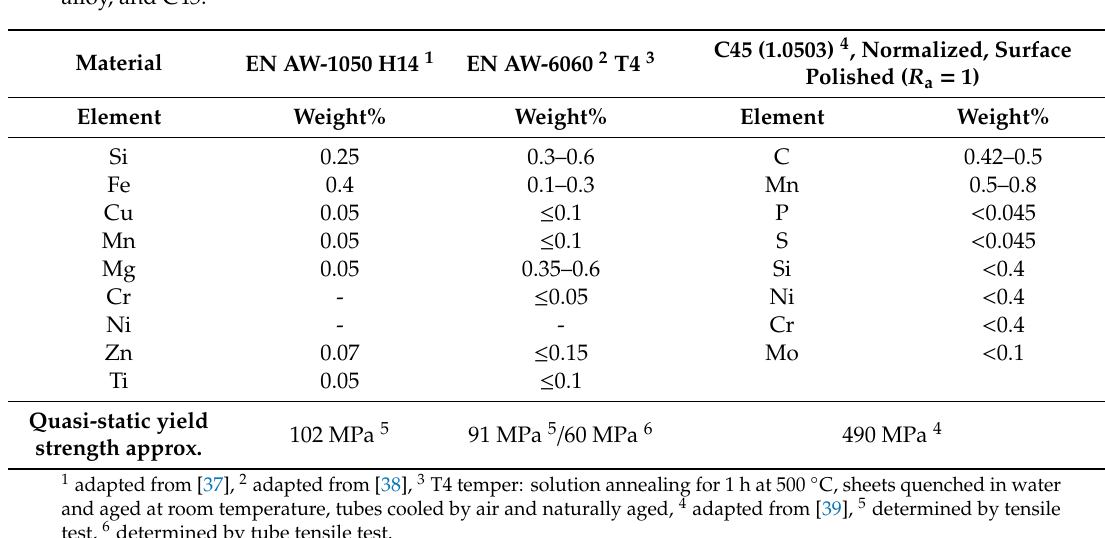
Table 3. Composition and quasi-static yield strength of aluminum EN AW-1050 alloy, EN AW-6060 alloy, and C45.